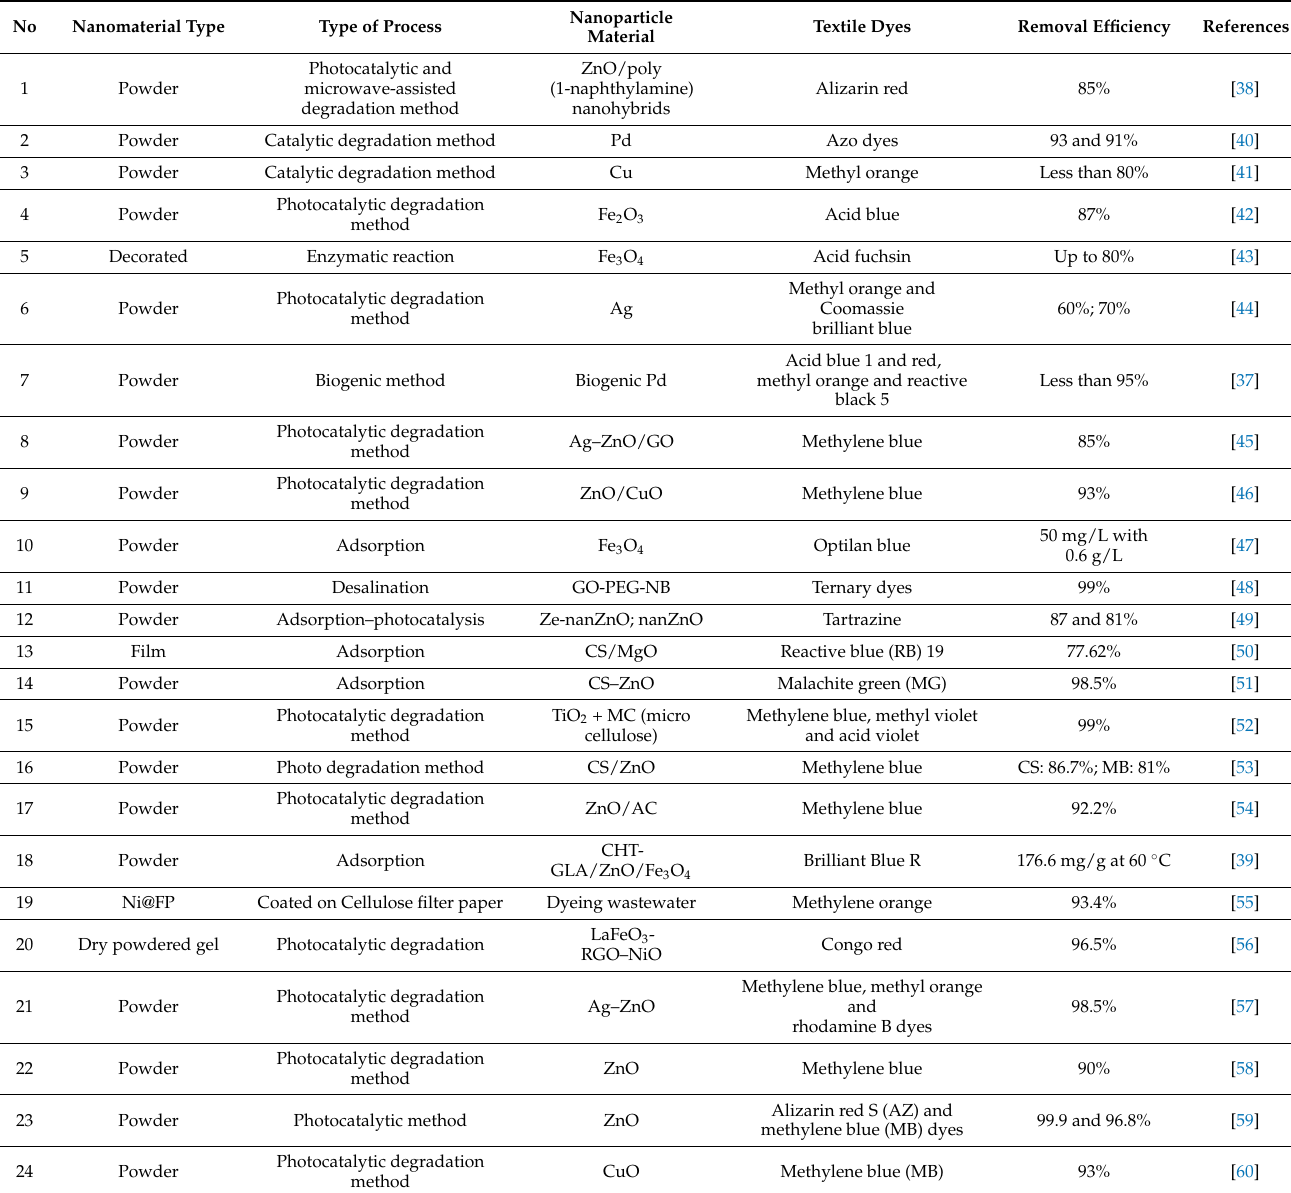
Table 1. Nanoparticles for textile dye